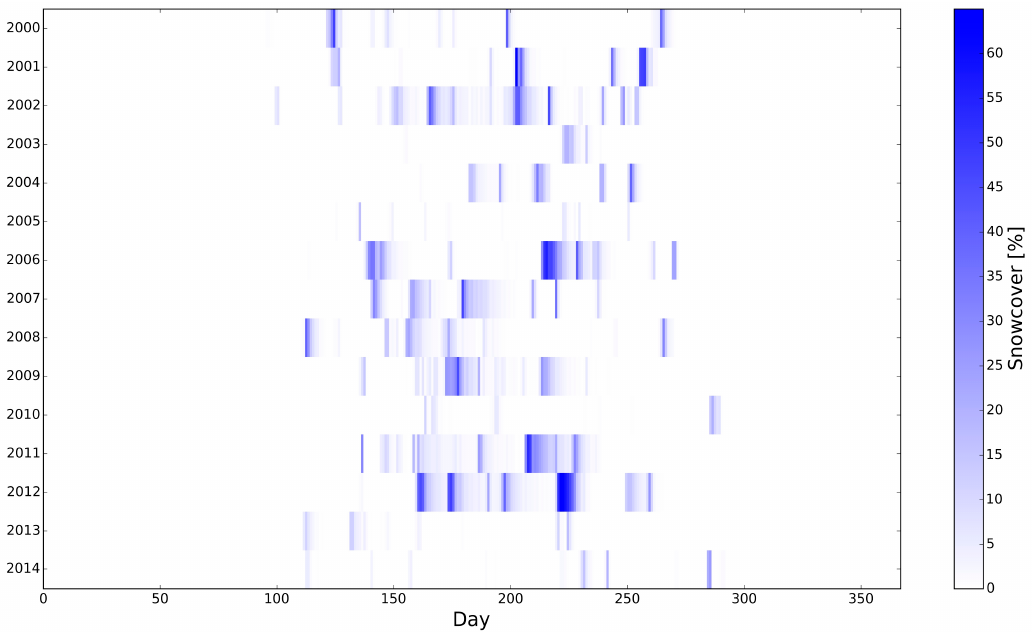
Figure 6. Daily distribution of snow covered area (%) between 2000 and 2014. The dark blue colors represent snow-covered areas that exceed 40% of the total land area; the light blue colors indicate areas in the highest mountain ranges in Lesotho with less than 15% of snow cover.